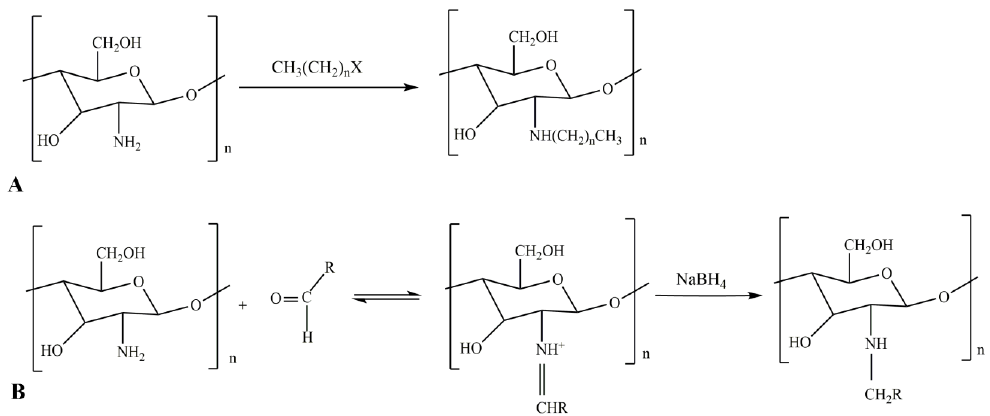
Figure 3. Alkylation chitosan derivative reaction equations. ( A ) Halogenated alkane to prepare N-alkylated chitosan; ( B ) advanced fatty aldehyde prepares N-alkylated